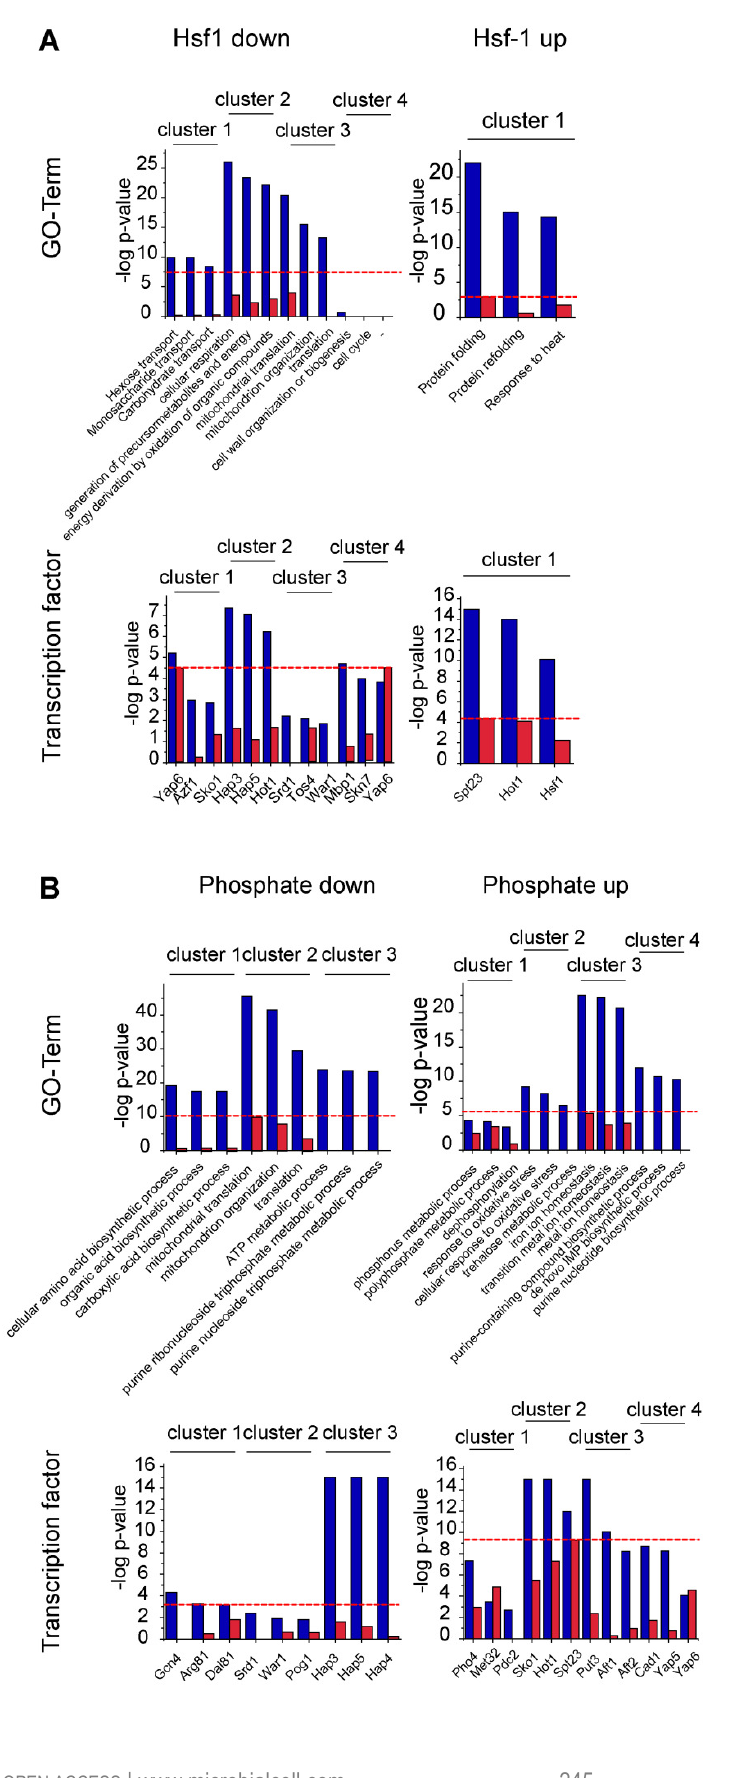
FIGURE 7: Biological processes and transcription factors of isolated clusters. Clusters are marked in Cytoscape as indicated in the corresponding figures (Figure 6, S3). The gene-ontology term (GO-term) biological process of the genes (upper panel) and the transcription factors regulating the genes (lower panel) of the isolated clusters (blue) and the full gene hit list (red) are depicted. The full analysis is listed in Table S2. The negative log of the p-value of the three highest ranking terms of the cluster analy- sis and the corresponding values of the full hit lists analysis are depicted. The red line marks the p-value of the best GO-term or transcription factor, when analyzing the non-clustered control of all hits. “-“ = analysis did not yield in any significant